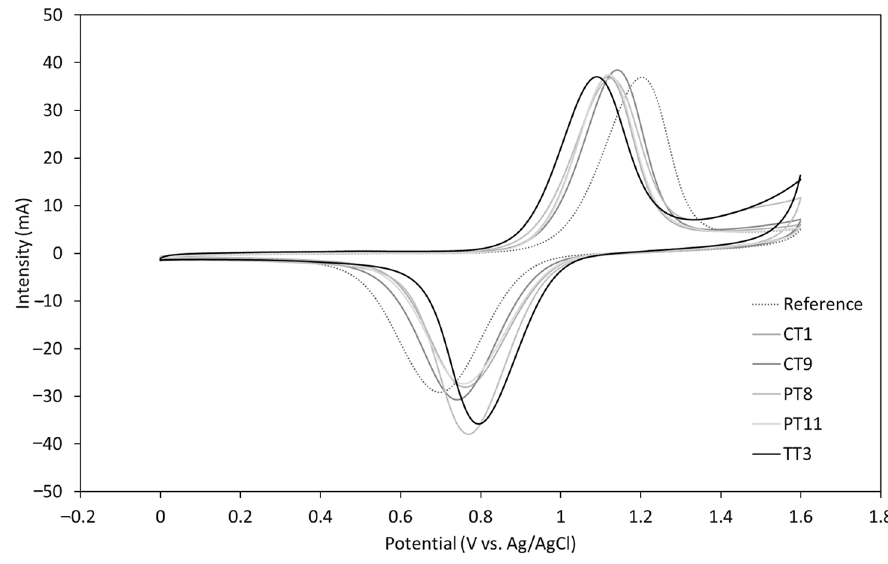
Figure 6. Voltammograms of the tested electrodes at a 10 mV/s scan rate. Table 6. Main parameters calculated from the voltammograms at a 10 mV/s scan rate for the different electrode treatments.